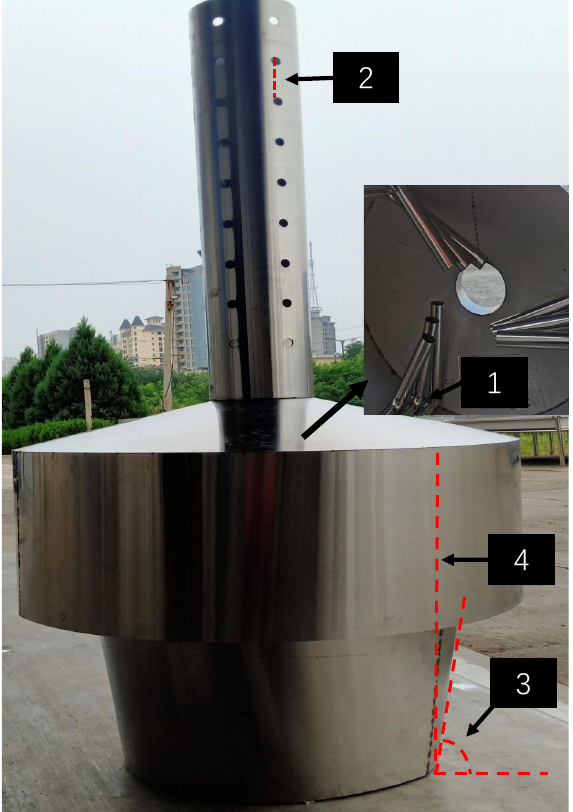
Figure 2. The schematic diagram of decision variables: 1. distance between the cover and the furnace body; 2. hole pitch; 3. opening angle; 4. height of the furnace